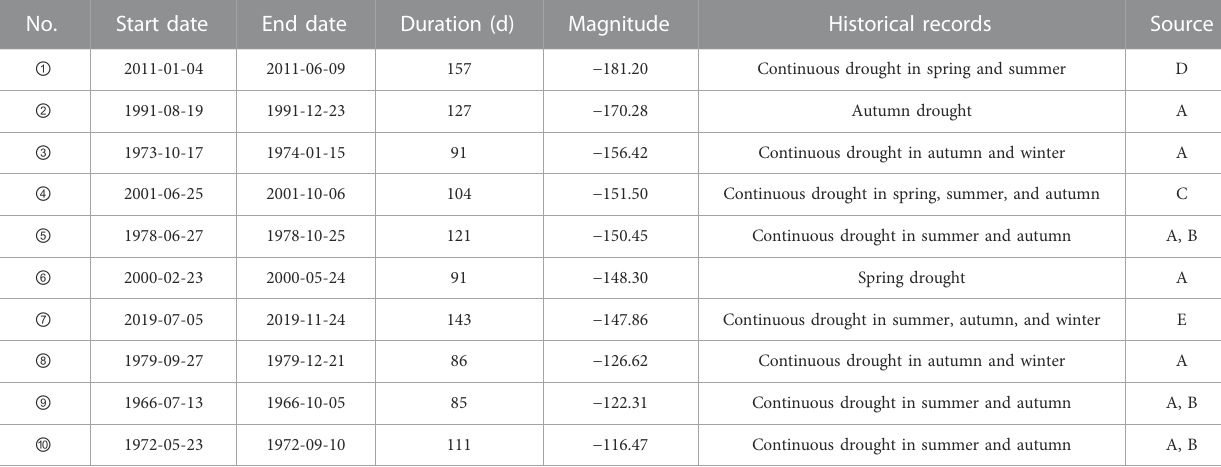
TABLE 1 Drought events with the ten largest magnitudes at the Wuhan station.